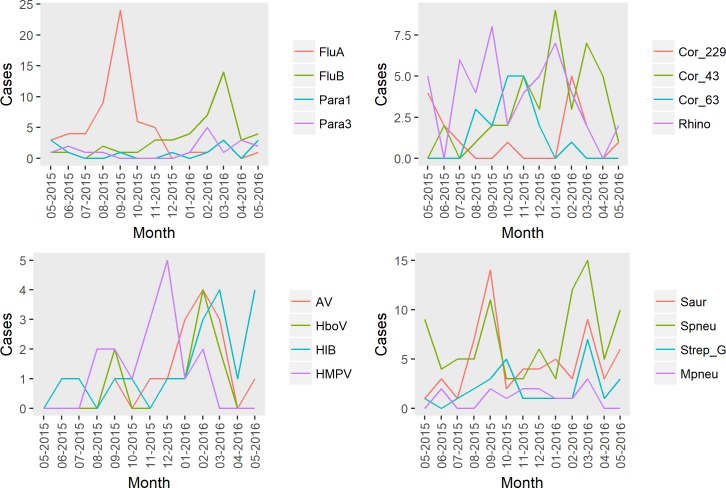
Number of cases by month for the 16 most commonly detected pathogens.